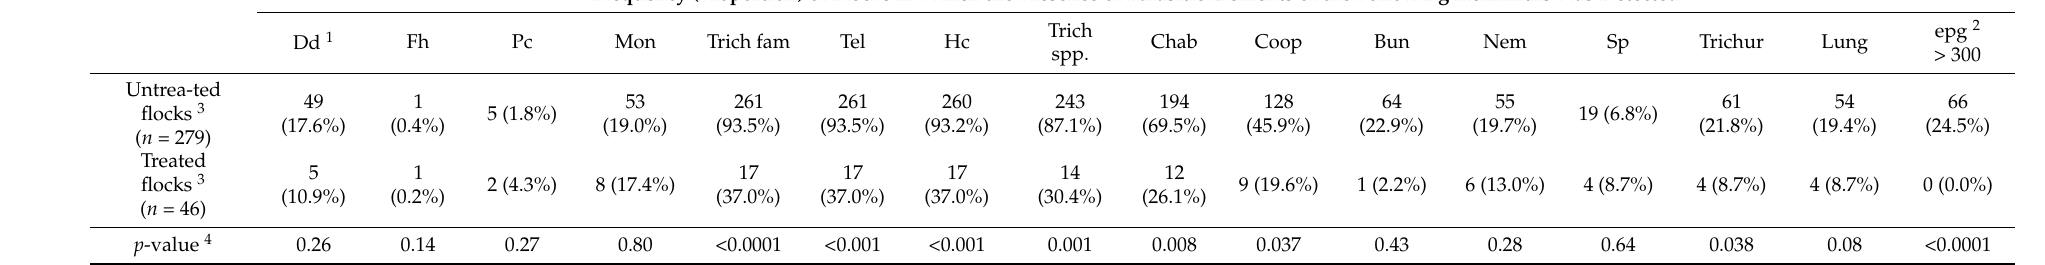
Table 2. The results of parasitological examinations in pooled faecal samples from 325 sheep flocks in a countrywide investigation in Greece, in accord with the administration of anthelmintic treatment during the two months prior to